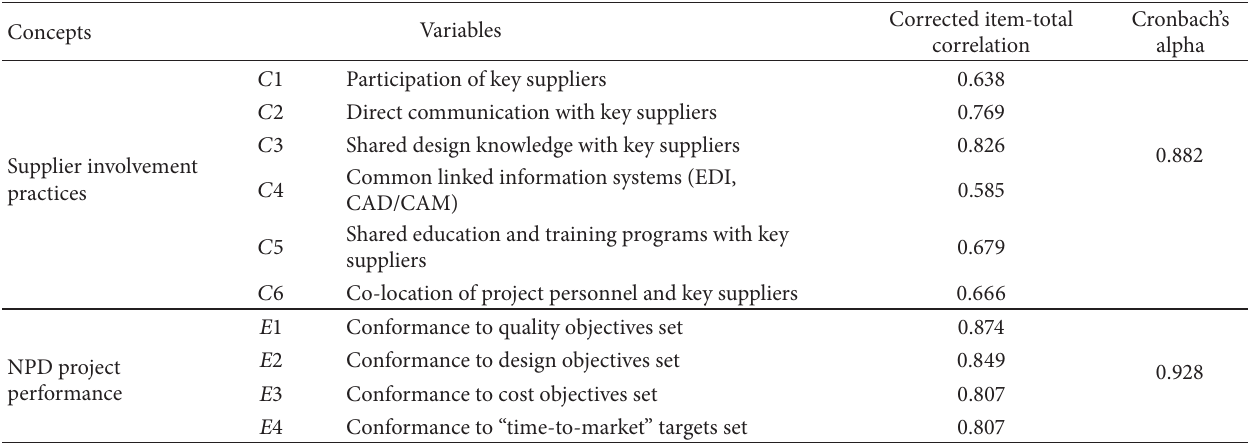
Table 3: The reliability of supplier involvement practices and NPD project performance.